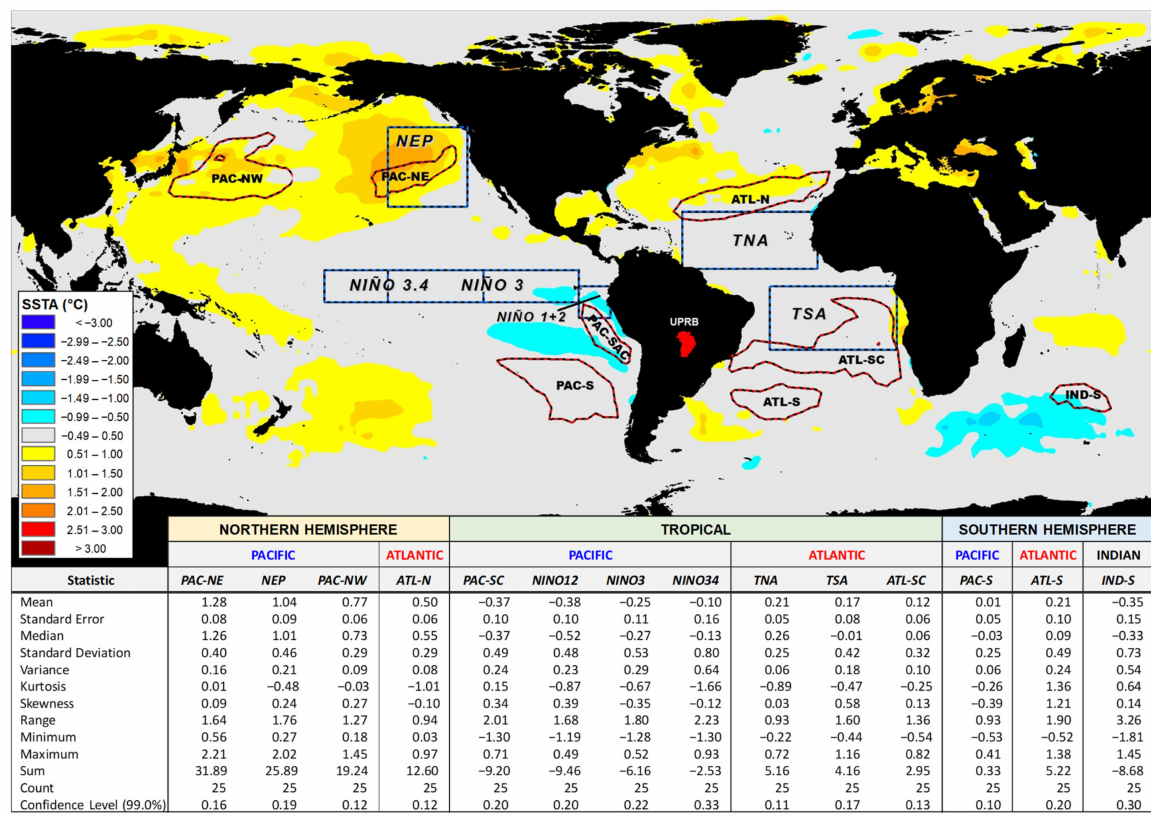
Figure 8. Mean Sea Surface Temperature Anomaly (SSTA, in ◦ C) and resulting statistics for series June 2019/June 2021 at different oceanic regions and at different SST indexes (see Figure